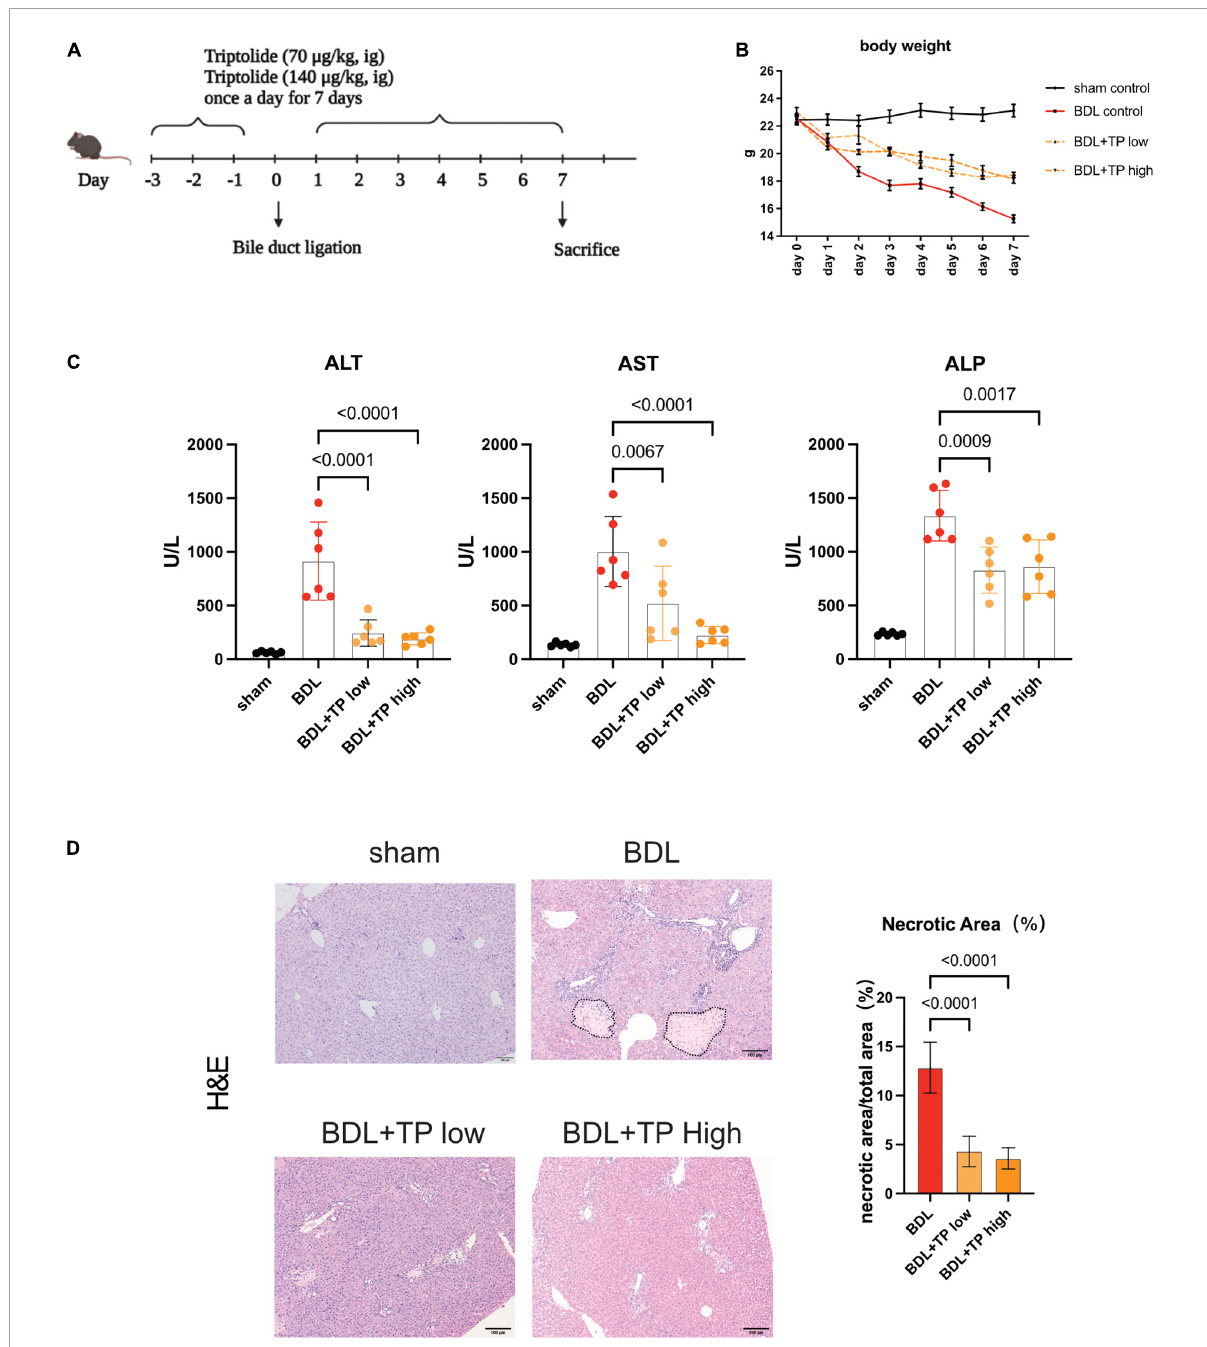
FIGURE1 Triptolide alleviates liver injury induced by bile duct ligation. Male C57BL/6 mice were sacrificed at seven days after BDL or sham surgery. (A) The diagrammatic experimental procedures. (B) Body weight of mice (each group n = 6). (C) Serum levels of ALT, AST and ALP in mice sacrificed at 7 days after BDL or sham surgery. (D) Representative images of H&E (The black dotted line indicates the necrotic area) from liver tissues. Necrosis area statistics of H&E. Scale Bar: 100 µ m. Data are shown as the mean ± SD. Data represent at least 6 independent experiments with triplicate measurements. Analysis of variance (one-way ANOVA) was used. p values represents significance different from BDL